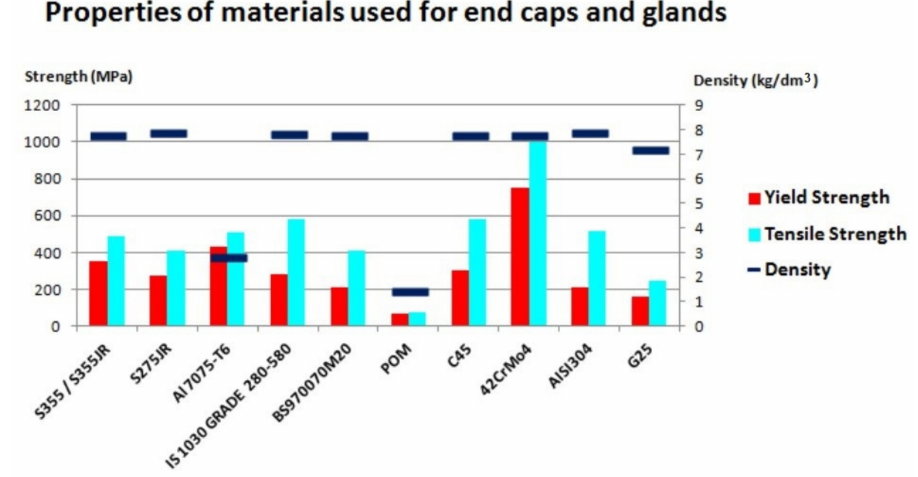
Figure 9. Chart of properties of the materials used for the end caps and